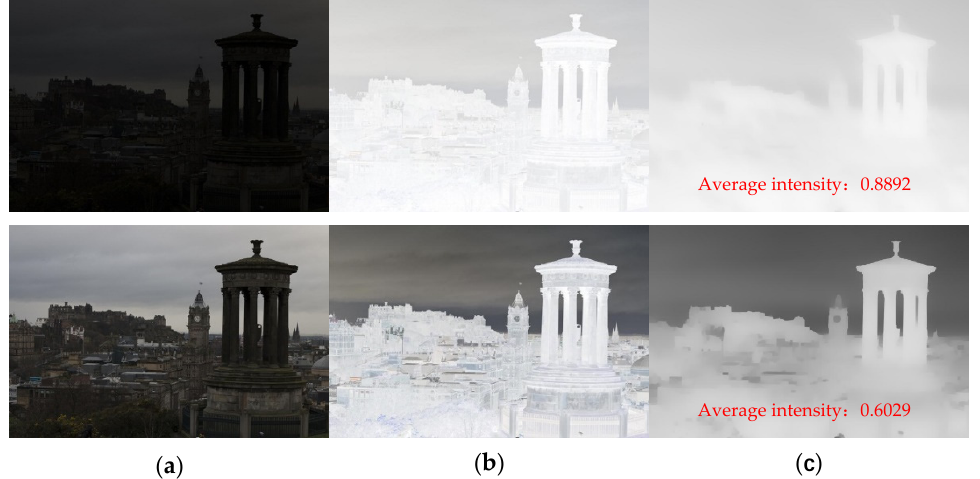
Figure 2. Relationship between low illumination image and its dark channel image. ( a ) Images at different exposure levels. ( b ) Inverse image corresponding to ( a ). ( c ) Dark channel map corresponding to ( b ).